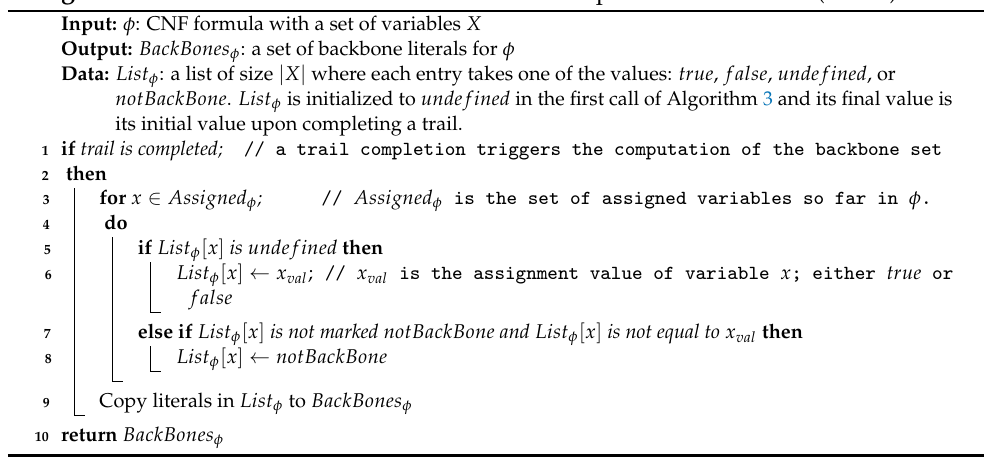
Algorithm 3: A backbone-based low-overhead computational heuristic